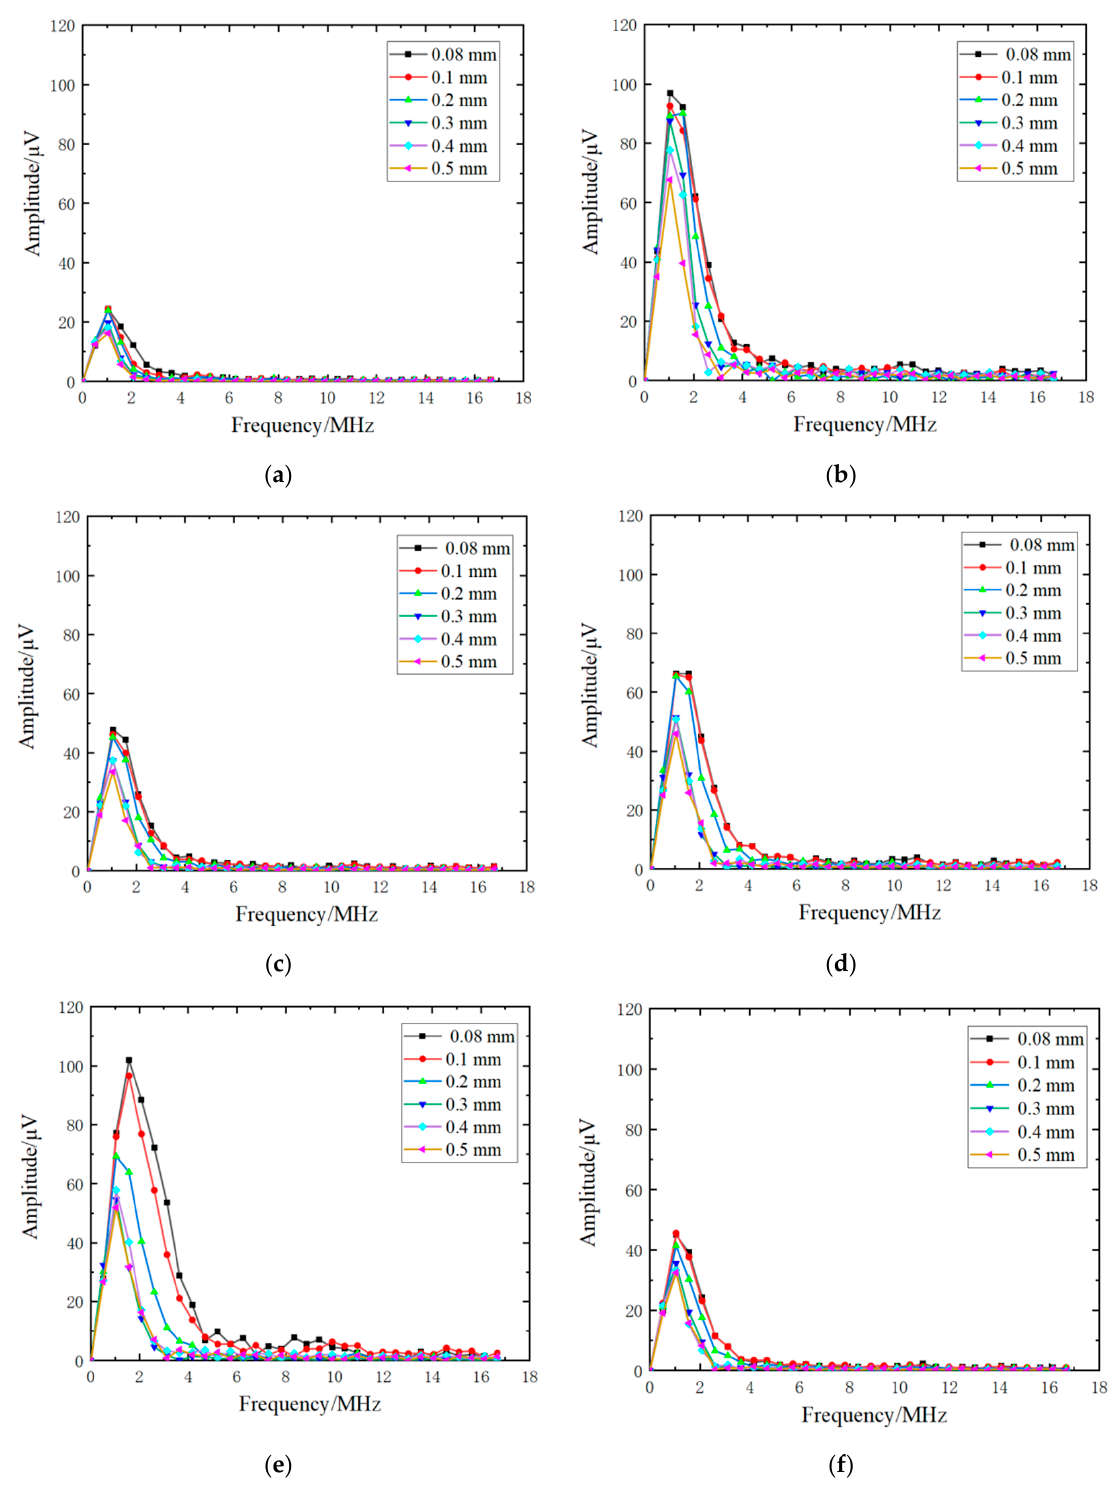
Figure 6. The frequency spectrum of the transmitted wave with a ( a ) pulse-rise time of 3 ns, ( b ) pulse-rise time of 10 ns, ( c ) laser-source power of 0.5 MW, ( d ) laser-source power of 0.7 MW, ( e ) laser-source radius of 80 mm, and ( f ) laser-source radius of 120 mm at the crack with a depth of 0.08 mm, 0.1 mm, 0.2 mm, 0.3 mm, 0.4 mm, and 0.5 mm.